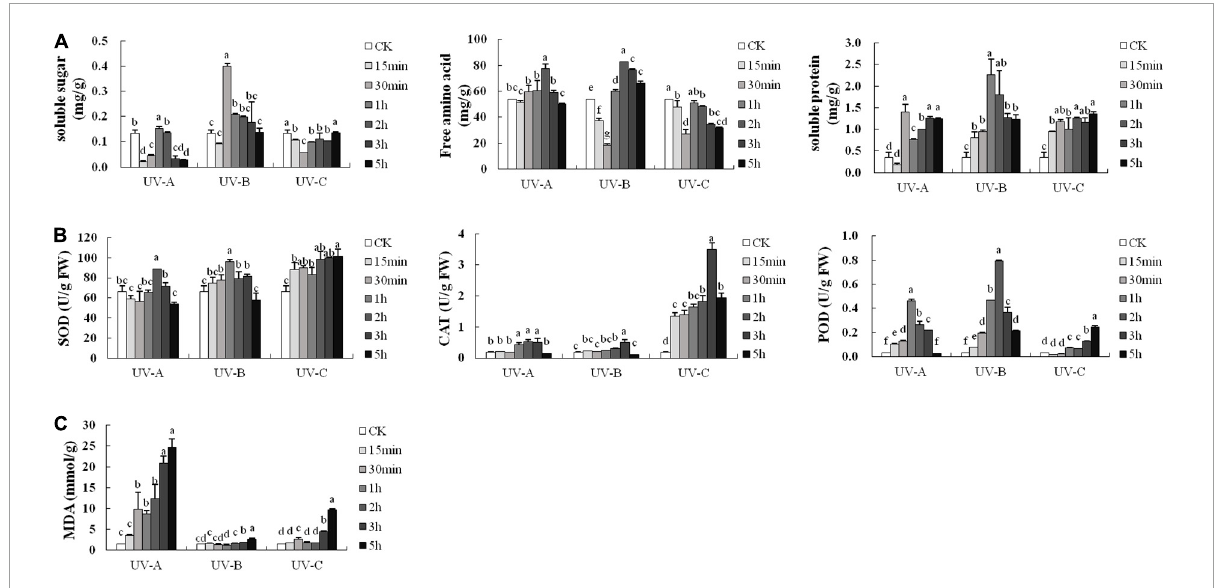
FIGURE6 Soluble substance contents (A) , antioxidant enzyme activities (B) , and malondialdehyde (MDA) contents (C) of leaves in Tetrastigma hemsleyanum with UV treatments. Different lowercase letters indicate a significant difference at 0.05 level ( P < 0.05).